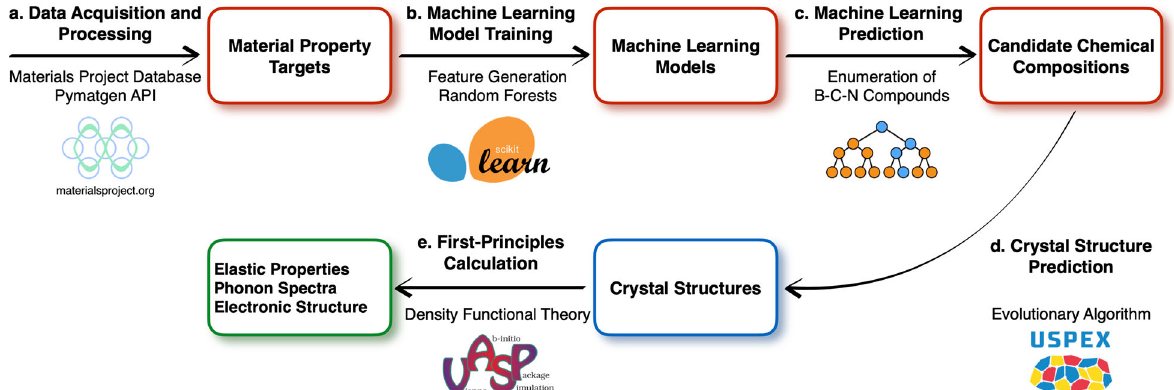
Fig. 1 Computational fl owchart of data-driven discovery of superhard materials. a Data acquisition and processing using the Materials Project 38 database and its application programming interface (API) PYMATGEN 60 . b Machine learning model training with handcrafted features and regression algorithms implemented in the SCIKIT-LEARN library 65 . c Random forests prediction of chemical compositions for candidate superhard materials. d Crystal structure prediction of a given chemical formula using evolutionary algorithms implemented in the USPEX program 76 – 78 . e First-principles validation of the machine learning results with density functional theory calculations using the VASP software 79,80 .